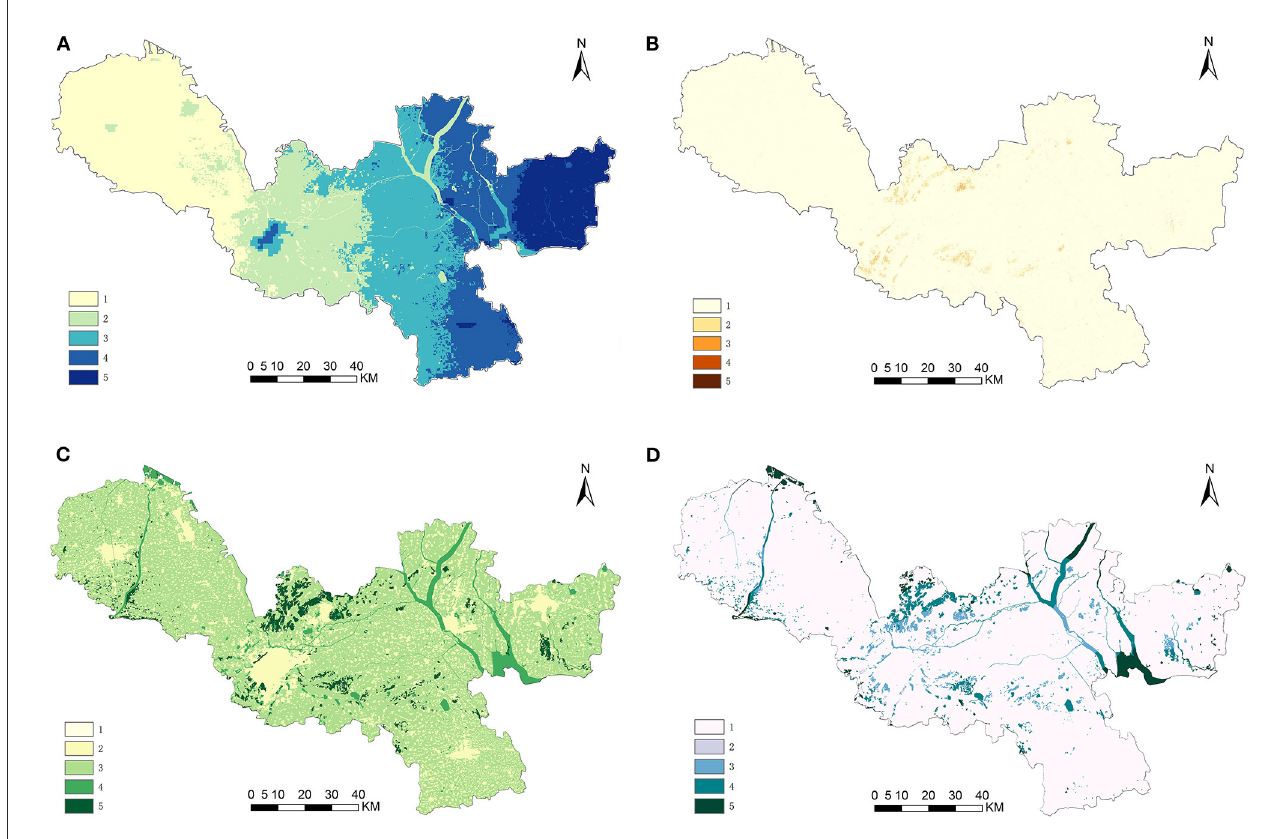
FIGURE4 Four types of ESs supply in Xuzhou (A) water yield, (B) soil conservation, (C) carbon storage, and (D) habitat